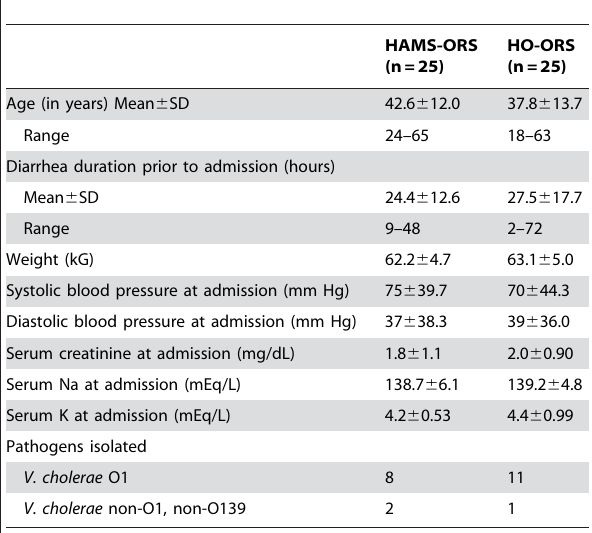
Table 2. Demographic characteristics of patients enrolled in the